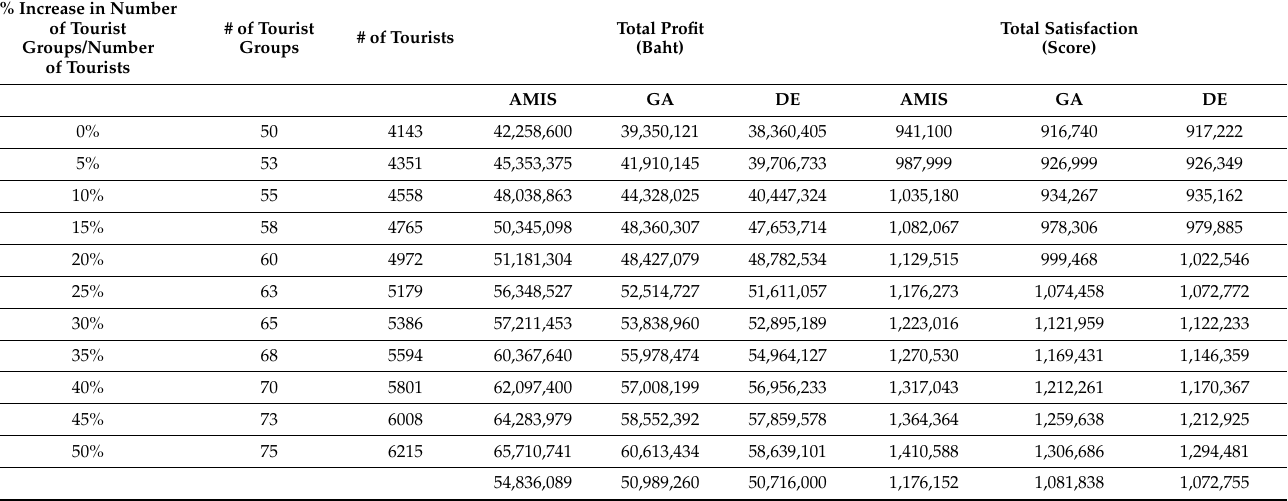
Table 11. Profit and total satisfaction of the proposed methods using different levels of number of tourists.